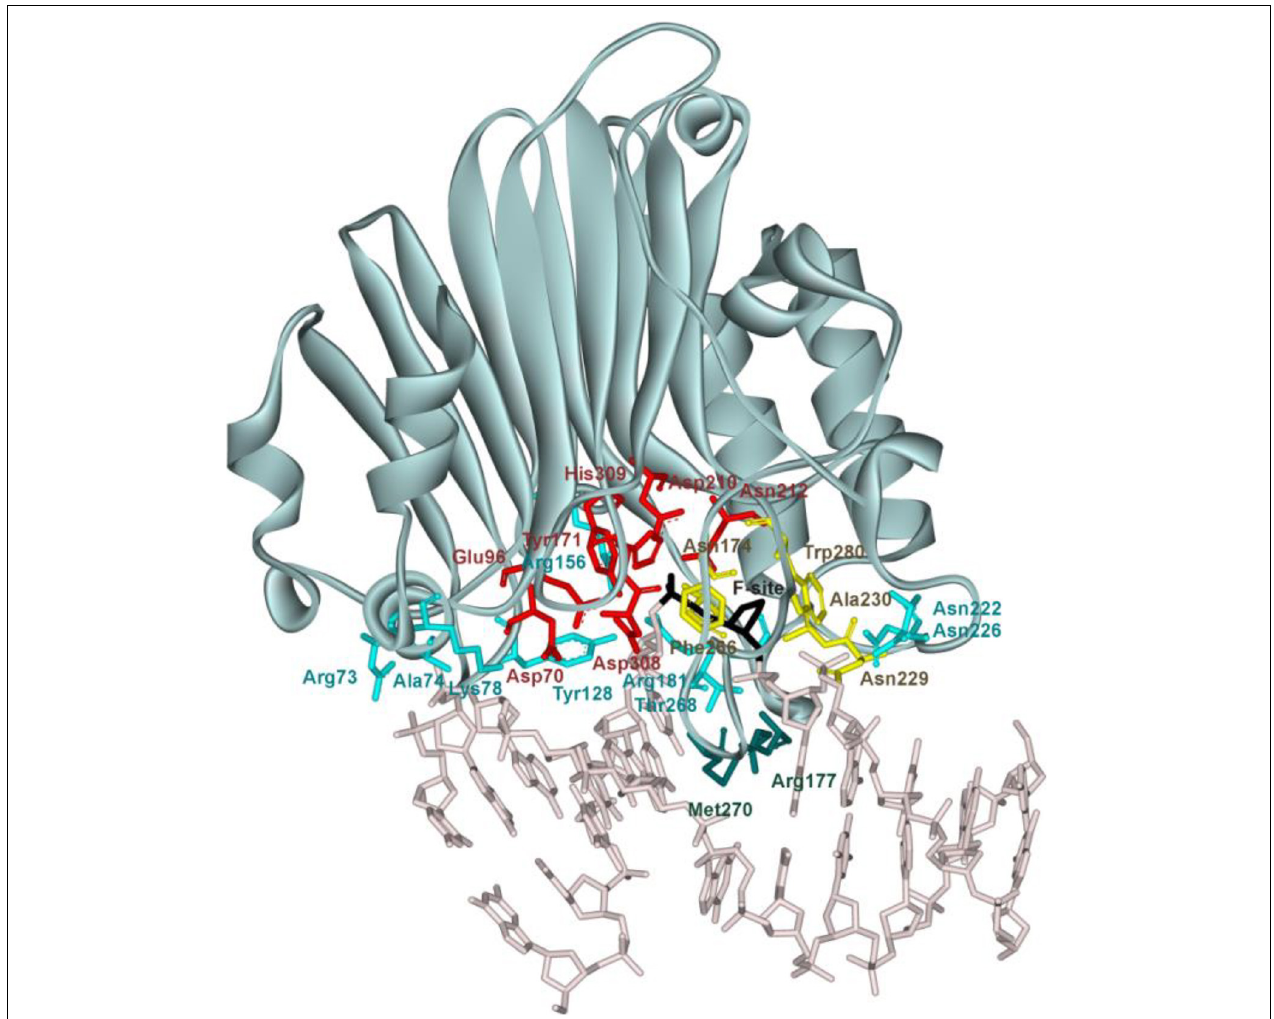
FIGURE 1 | The structure of hAPE1 complexed with DNA containing an F-site (Protein Data Bank ID 1DE8). Catalytic amino acid residues Asp70, Glu96, Tyr171, Asp210, Asn212, Asp308, and His309 (red); amino acid residues of the DNA-binding site Arg73, Ala74, Lys78, Tyr128, Arg156, Arg181, Asn222, Asn226, and Thr268 (blue); intercalating amino acids Met270 and Arg177 (green); and residues Asn174, Asn229, Ala230, Phe266, and Trp280 forming a damaged base-binding pocket (yellow) are highlighted, as is the F-site